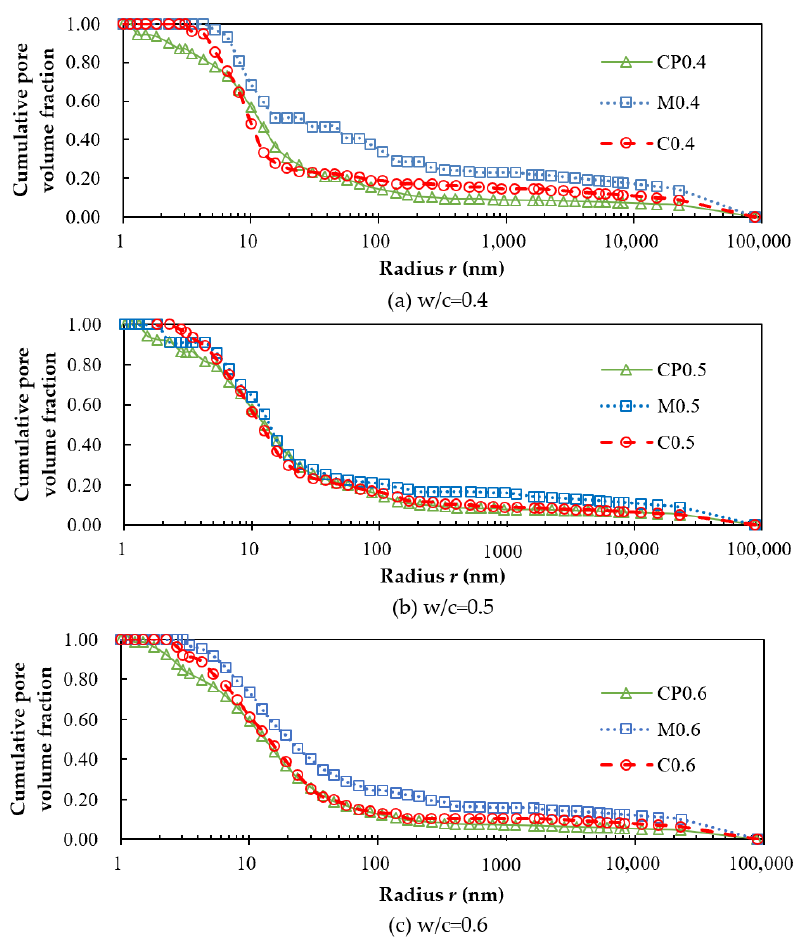
Figure 4. Cumulative pore volume fraction curves of cement paste, mortar, and concrete with the w/cs of: ( a ) 0.4; ( b ) 0.5; ( c ) 0.6.